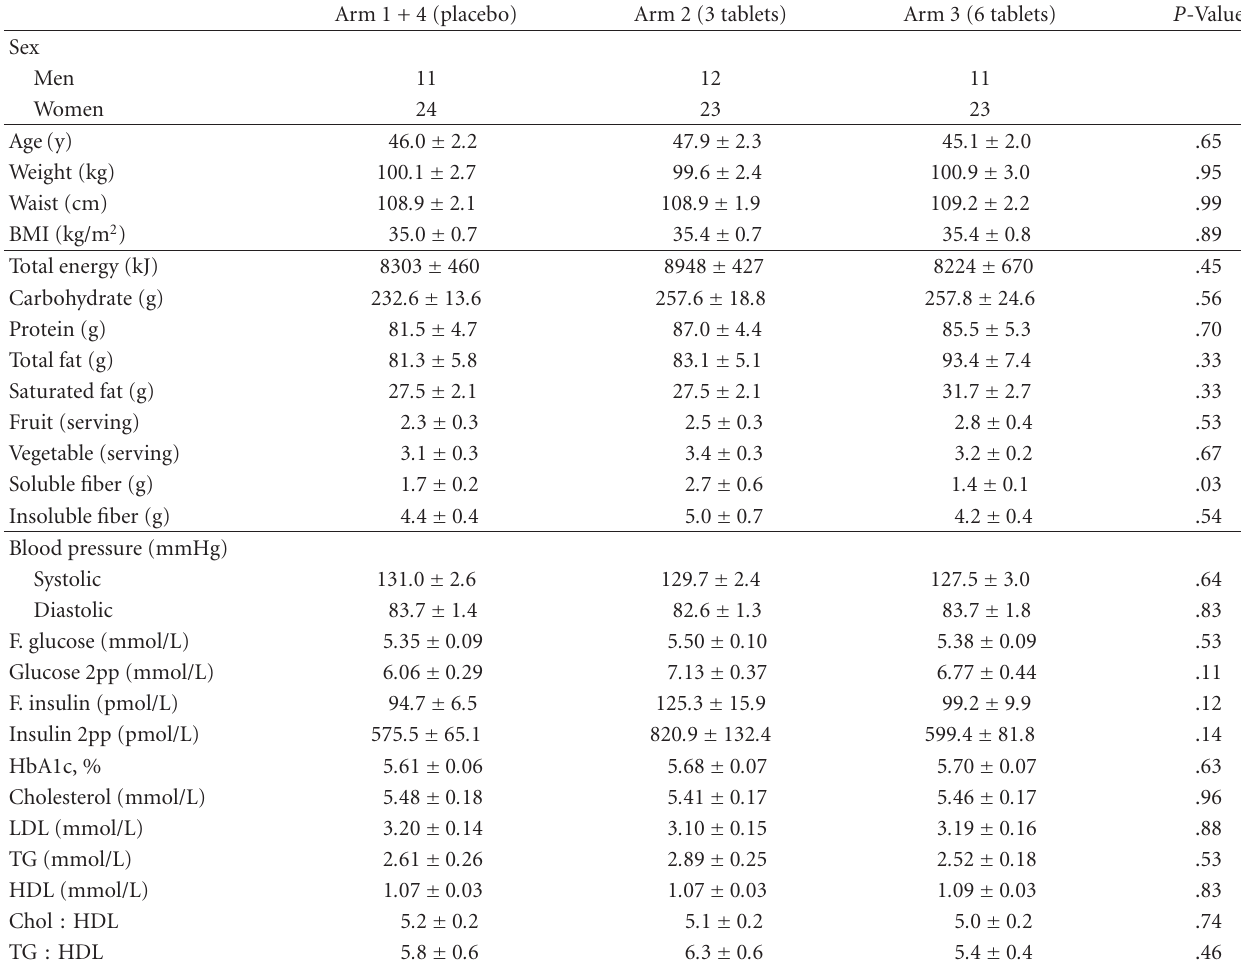
Table 2: Baseline anthropometrics, dietary intake, glucose metabolism, and lipid parameters of study participants by treatment